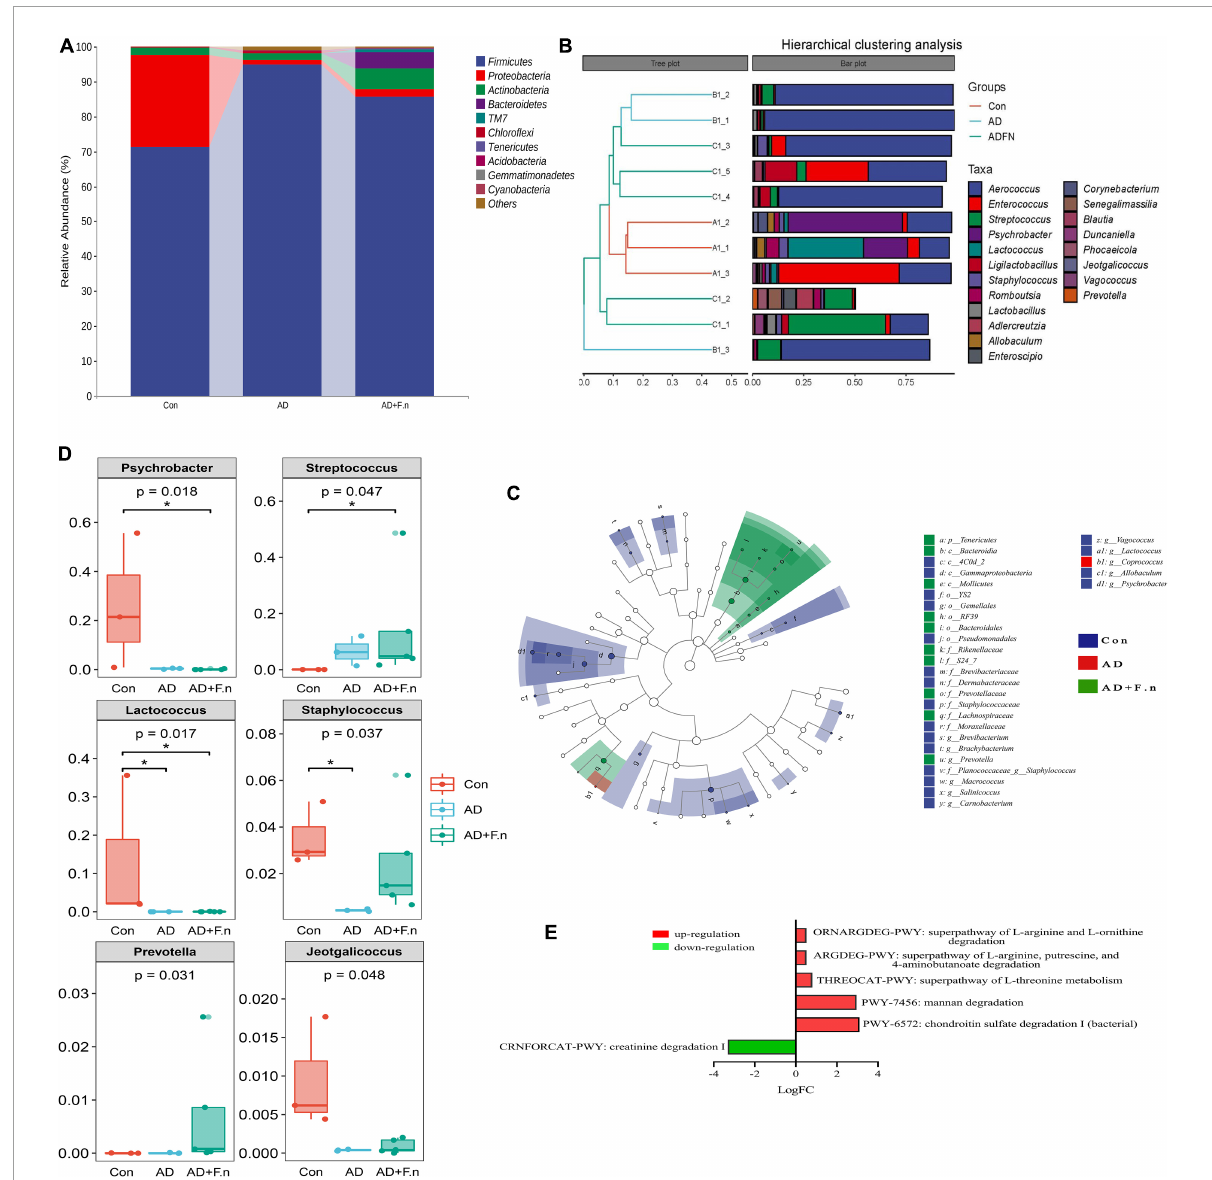
FIGURE6 Gut microbiota composition and metabolism. (A) Classification and abundance of fecal bacteria at the phylum level (top 10) in each group. (B) Taxonomic classification and hierarchical clustering analysis of the bacterial communities at the genus levels from three groups (top 20). (C) The enriched taxa in the feces of rats were displayed in cladograms. (D) Significant difference in relative abundances of top 20 bacteria at the genus level in three groups. (E) Predicting metabolic pathways in MetaCyc, * P <